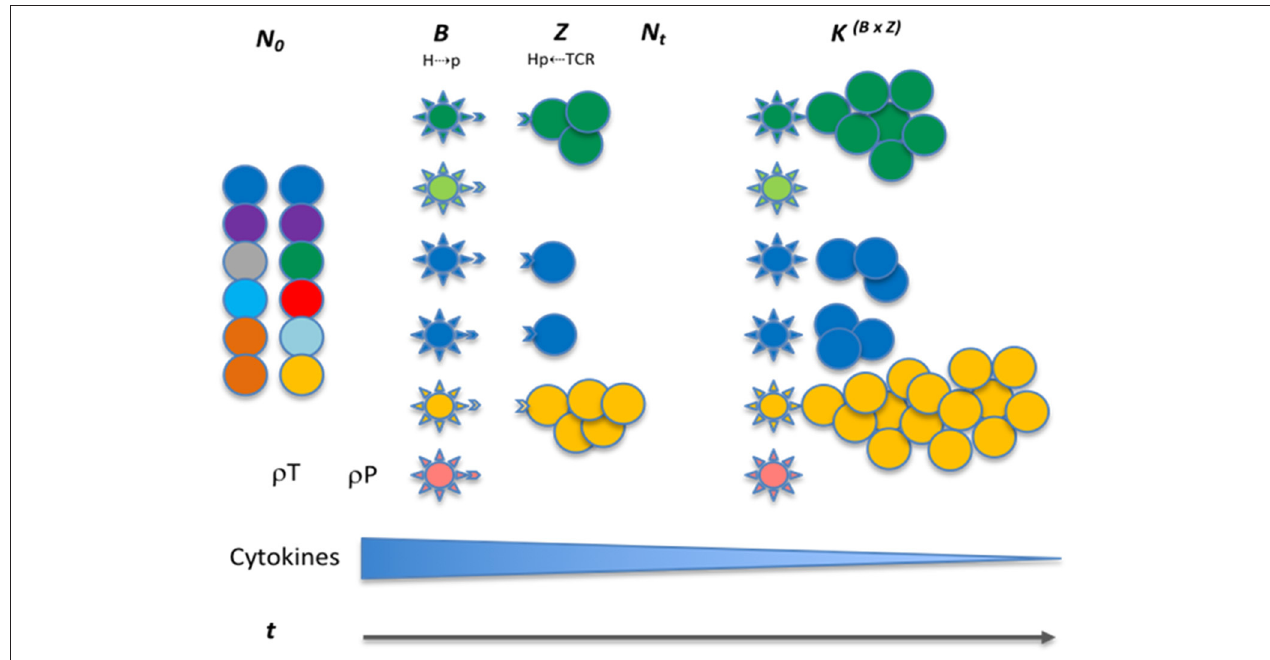
FIGURE 4 | Interaction between donor T cells and recipient antigens presented on APC. Colored circles show different T cell clones with variable antigen affinity. The spiked spheres show antigen presenting cells with HLA molecules, colors indicate unique peptide antigens and correspond to T cell recognition. T cell growth is indicated over time in response to various influences, i.e. peptide affinity for HLA molecules (Vector B ), and TCR affinity for HLA-peptide complex (vector Z ), both leading to T cell growth. The infused allograft contains T cells with TCR of varying peptide antigen specificity (different colors), these may encounter peptides for which they have affinity (no color difference between APC and T cells), leading to growth. This variability makes antigen response a probability function of the likelihood of T cell presence and peptide antigen presentation ( ρ P & ρ T ). The expression level is depicted by more cells presenting the same antigen, making up for weak affinity driving proliferation. The cytokines made by APCs get taken up by the cytokine receptors on the T cells, leading to a diminishing effect as the T cell repertoire